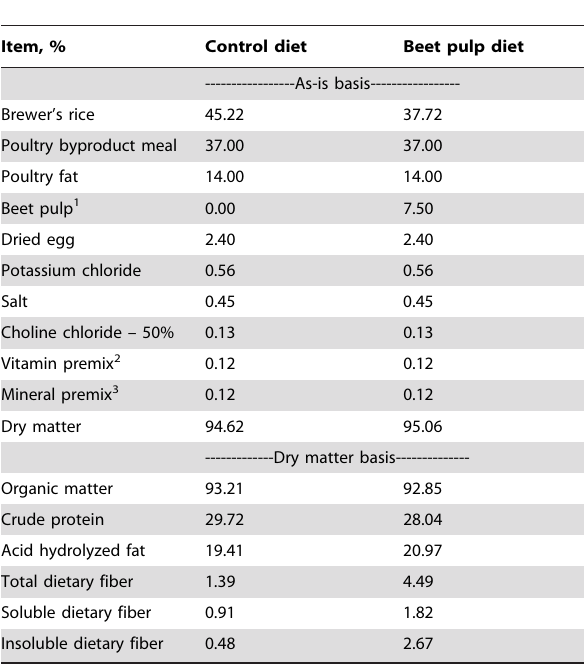
Table 2. Ingredient and nutrient composition of diets fed to adult dogs to evaluate gut microbiome